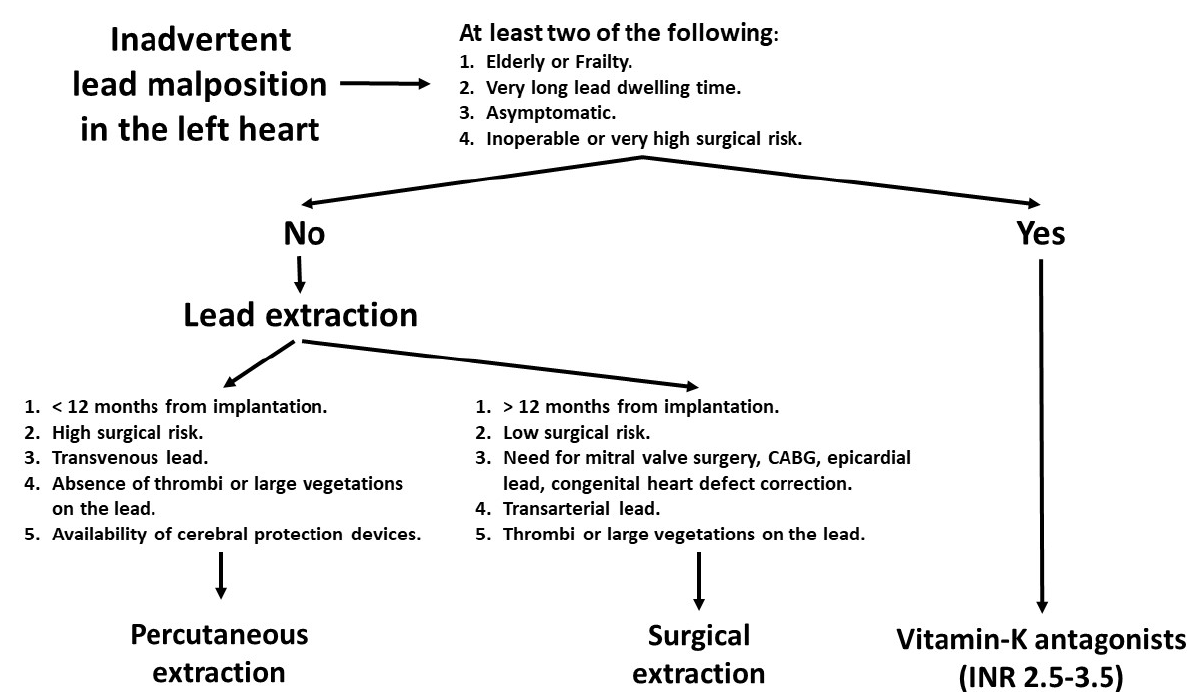
Figure 3. Suggested treatment algorithm. Asymptomatic patients with very high surgical risk can be managed conservatively with vitamin K antagonists and INR between 2.5 and 3.5. For patients suitable for lead extraction, the surgical procedure can be preferred if the lead dwelling time is more than one year, the embolization risk is high, the lead is placed through the arterial route and if additional interventions must be performed (e.g., epicardial leads, congenital heart defect repair).